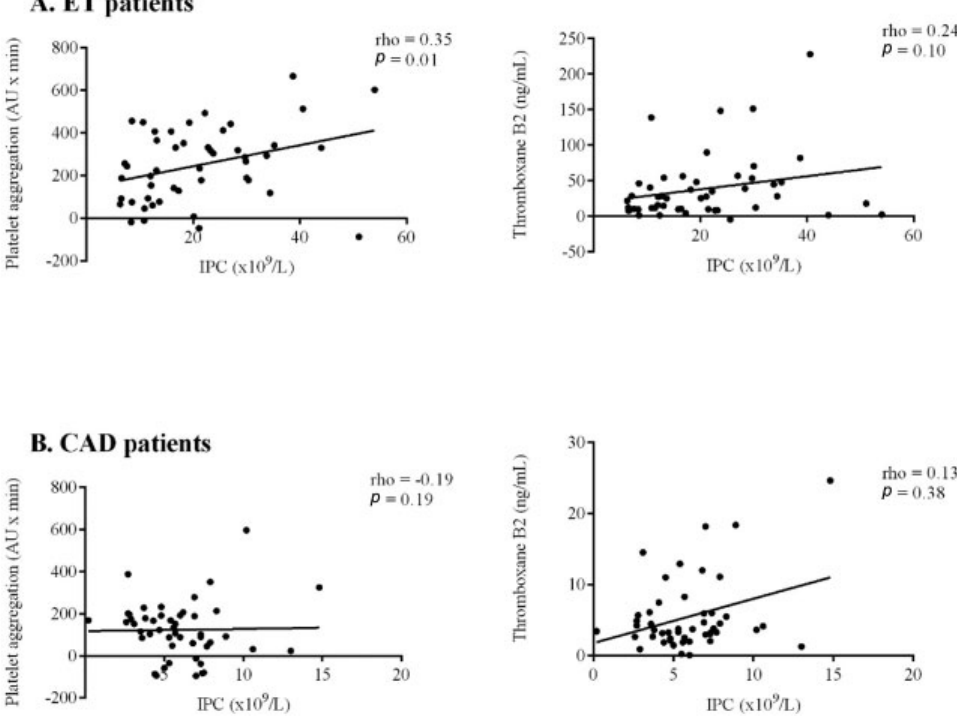
Fig. 3 Correlation between immature platelet count (IPC) and (1) difference in platelet aggregation between 24 and 1hour and (2) difference in thromboxane B 2 levels between 24 and 1hour in A : 48 patients with essential thrombocythemia (ET) and B : 48 patients with coronary artery disease